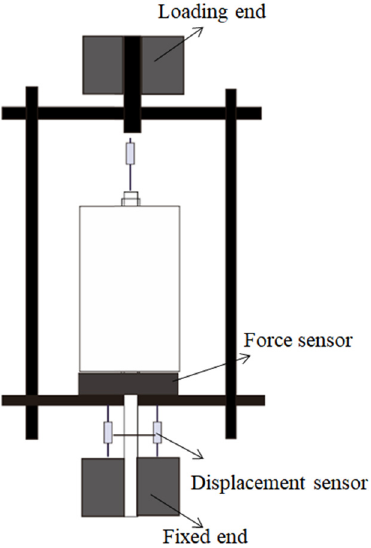
Figure 2: Loading diagram.